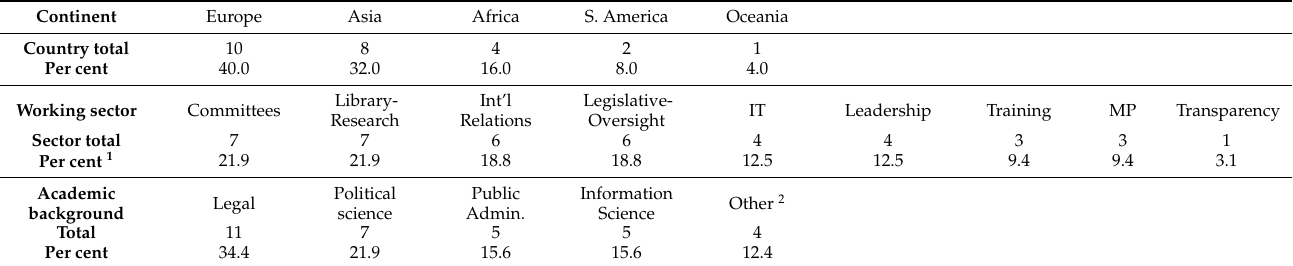
Table A1. Basic sample